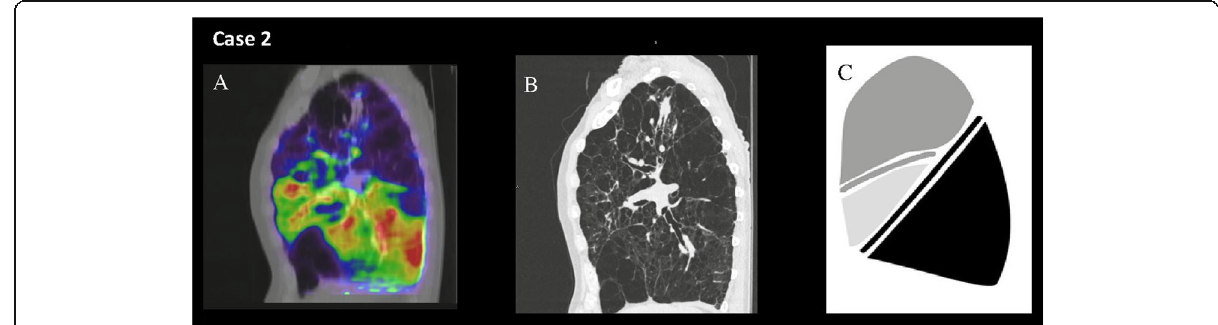
Fig. 3 Highlighted are sagittal fused 68Ga-VQ/PET-CT ( a ), CT densitometry ( b ), and StratX® report ( c ) images from a participant (case 2) demonstrating discordance in modalities in the lower lobes, with high perfusion to lower lobe despite high destruction scores based on CT densitometry. Panel A depicts the right lung with perfusion in color (RUL 42%, RML 12%, RLL 14%), with b showing the CT density. Panel C It indicates right lower lobe having the highest destruction score (70%) despite functional imaging suggesting it had an adequate level of perfusion with one of the higher lobar percentages of normal ventilation/perfusion